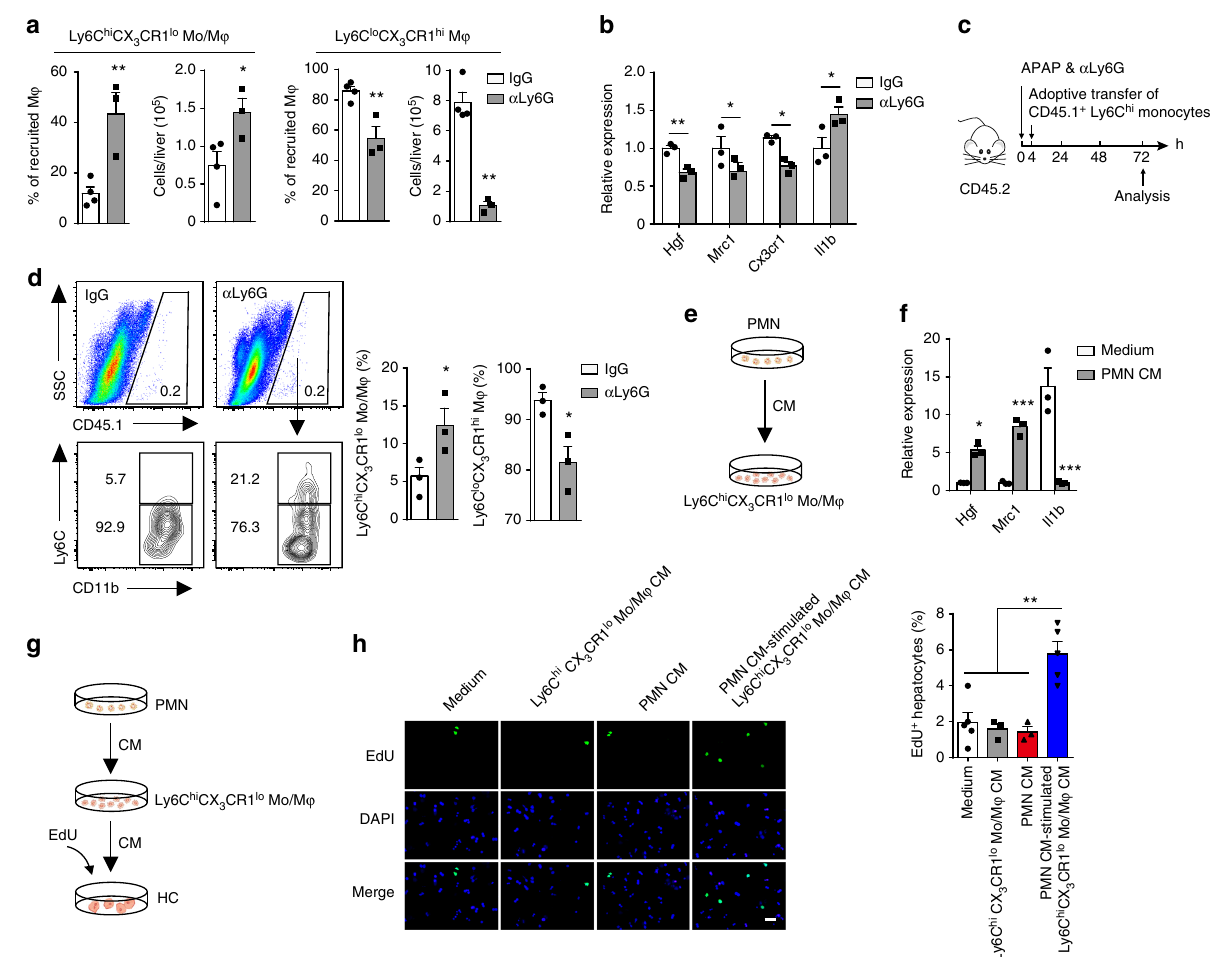
Fig. 2 Neutrophils mediate development of reparative macrophages. a , b Mice were treated with anti-Ly6G mAb or IgG at 6 h after APAP challenge. The percentage and number of the indicated macrophage subsets at 72 h were determined ( a ). n = 4, 3. Experiment was repeated three times. Gene expression in 72 h hepatic monocyte-derived macrophages following neutrophil depletion was measured by qPCR, presented relative to Gapdh ( b ). n = 3. Experiment was repeated three times. c , d Schematic of the experimental design: CD115 + Ly6C hi monocytes enriched with CD45.1 mice were adoptively transferred into neutrophil-depleted CD45.2 mice at 4 h after APAP challenge ( c ). The transferred CD45.1 + monocytes in the livers of recipient mice harvested at 72 h were identi fi ed ( d ). n = 3. Experiment was repeated twice. e , f Schematic of the experimental design: 24 h Ly6C hi CX 3 CR1 lo monocytes/macrophages were exposed to the conditioned medium (CM) of 24 h hepatic neutrophils ( e ). The expression of the indicated genes in Ly6C hi CX 3 CR1 lo monocytes/ macrophages was detected by qPCR ( f ). n = 3. Experiment was repeated three times. g , h Schematic of the experimental design: Hepatocyte proliferation was induced with the supernatants from 24 h Ly6C hi CX 3 CR1 lo monocytes/macrophages that had been co-cultured with the CM of 24 h neutrophils compared to the supernatants from the 24 h Ly6C hi CX 3 CR1 lo monocytes/macrophages or neutrophils cultured alone ( g ). Hepatocytes undergoing DNA synthesis after co-culture were visualized using a EdU Imaging Kit. The EdU-positive cells were then quanti fi ed ( h ). The bar graph indicates 50 μ m. n = 5, 3, 3, 5. Experiment was repeated twice. The results represent mean ± s.e.m. (* P < 0.05, ** P < 0.01, *** P < 0.001). P values were calculated by